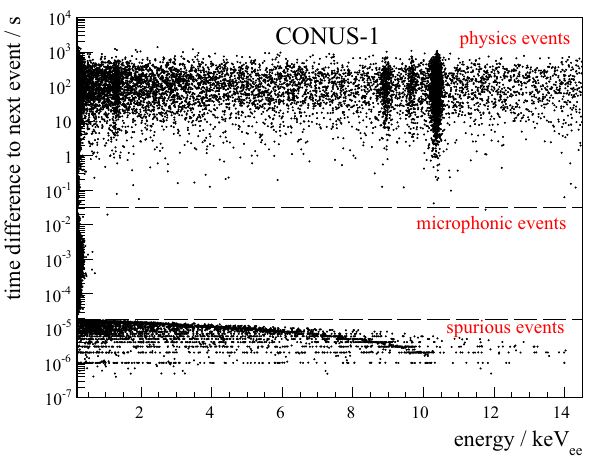
Fig. 13 Timedifferencedistributionasfunctionofenergy,asmeasured with C1 during Run -1. Two dotted lines at Δ t = 0 . 03s (10 − 1 . 5 s) and Δ t = 25 µ s(10 − 4 . 6